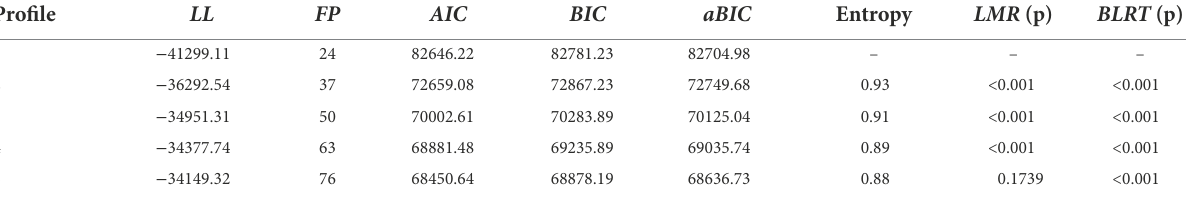
TABLE 2 Fit indices for one-to five-profile models of latent profile analysis. Profile